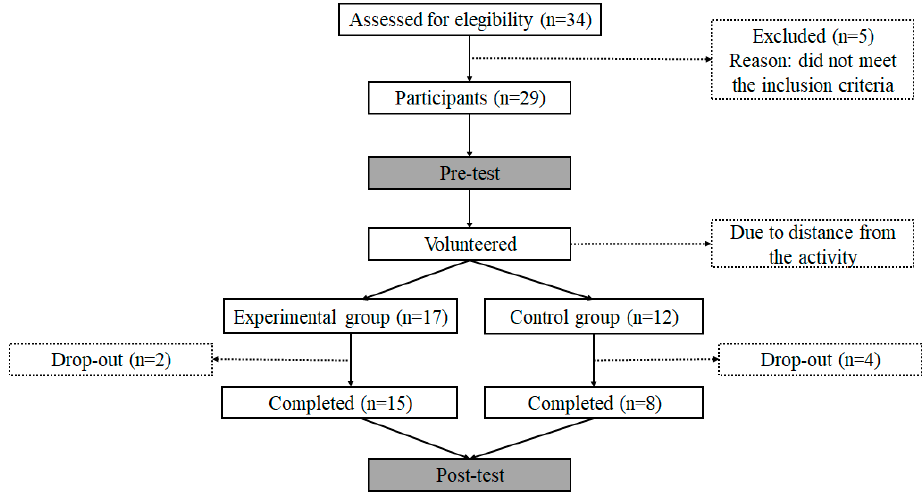
Figure 1. Flow chart of the inclusion process.